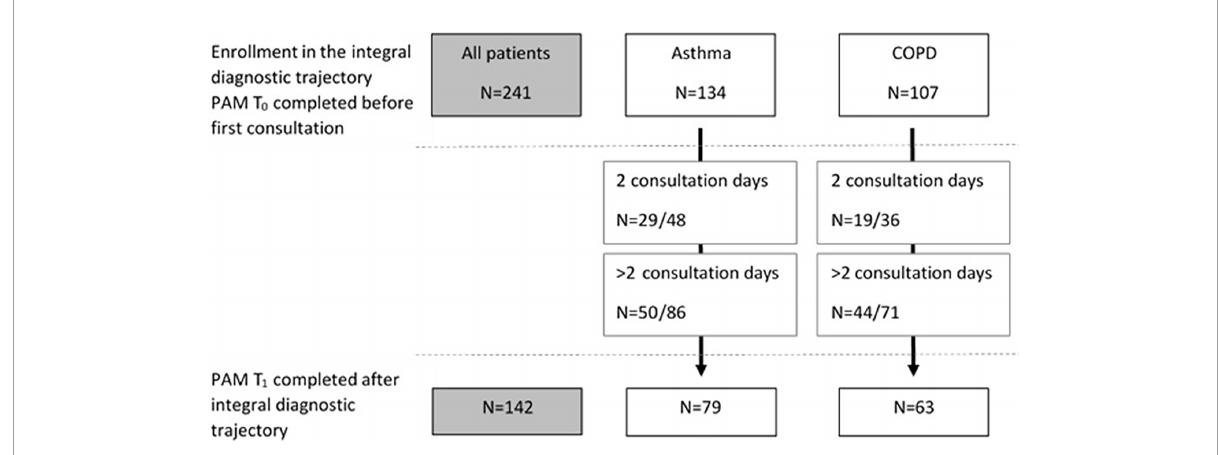
FIGURE2 Flowchart of patients who completed the PAM at baseline (T 0 ) and number of patients who completed the PAM after the intervention (T 1 ), for the whole group and for asthma and COPD separately. For both groups the numbers of patients who completed T 1 of those with two consultations and number of patients who completed T 1 of those with more than two consultations are included.